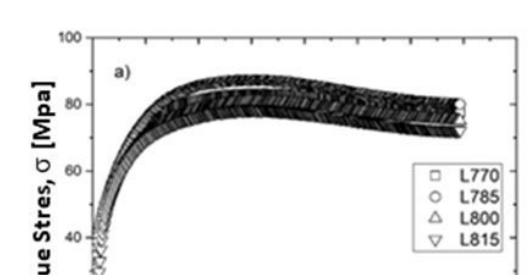
Figure 4. Experimental compression strain curves at different temperatures and strain rate of a) 0.1 s -1 , b) 0.01 s -1 , and c) 0.001 s -1 medium carbon steel.